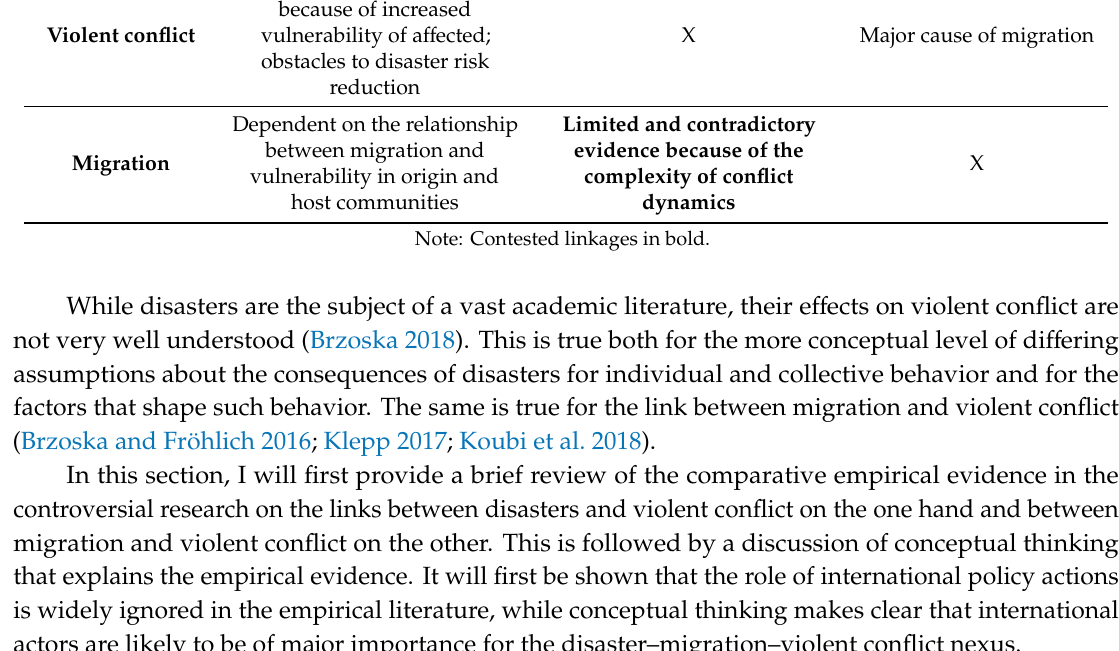
Table 1. Linkages between weather- and climate-related disasters, violent conflict and migration. Consequences for “Cause” Disasters Violent conflict Migration Limited and contradictory Major cause of migration, evidence because of the Disasters X but often local and short complexity of conflict term dynamics Generally strong e ff ects because of increased Violent conflict vulnerability of a ff ected; X Major cause of migration obstacles to disaster risk reduction Limited and contradictory Dependent on the relationship evidence because of the between migration and Migration X complexity of conflict vulnerability in origin and dynamics host communities Note: Contested linkages in